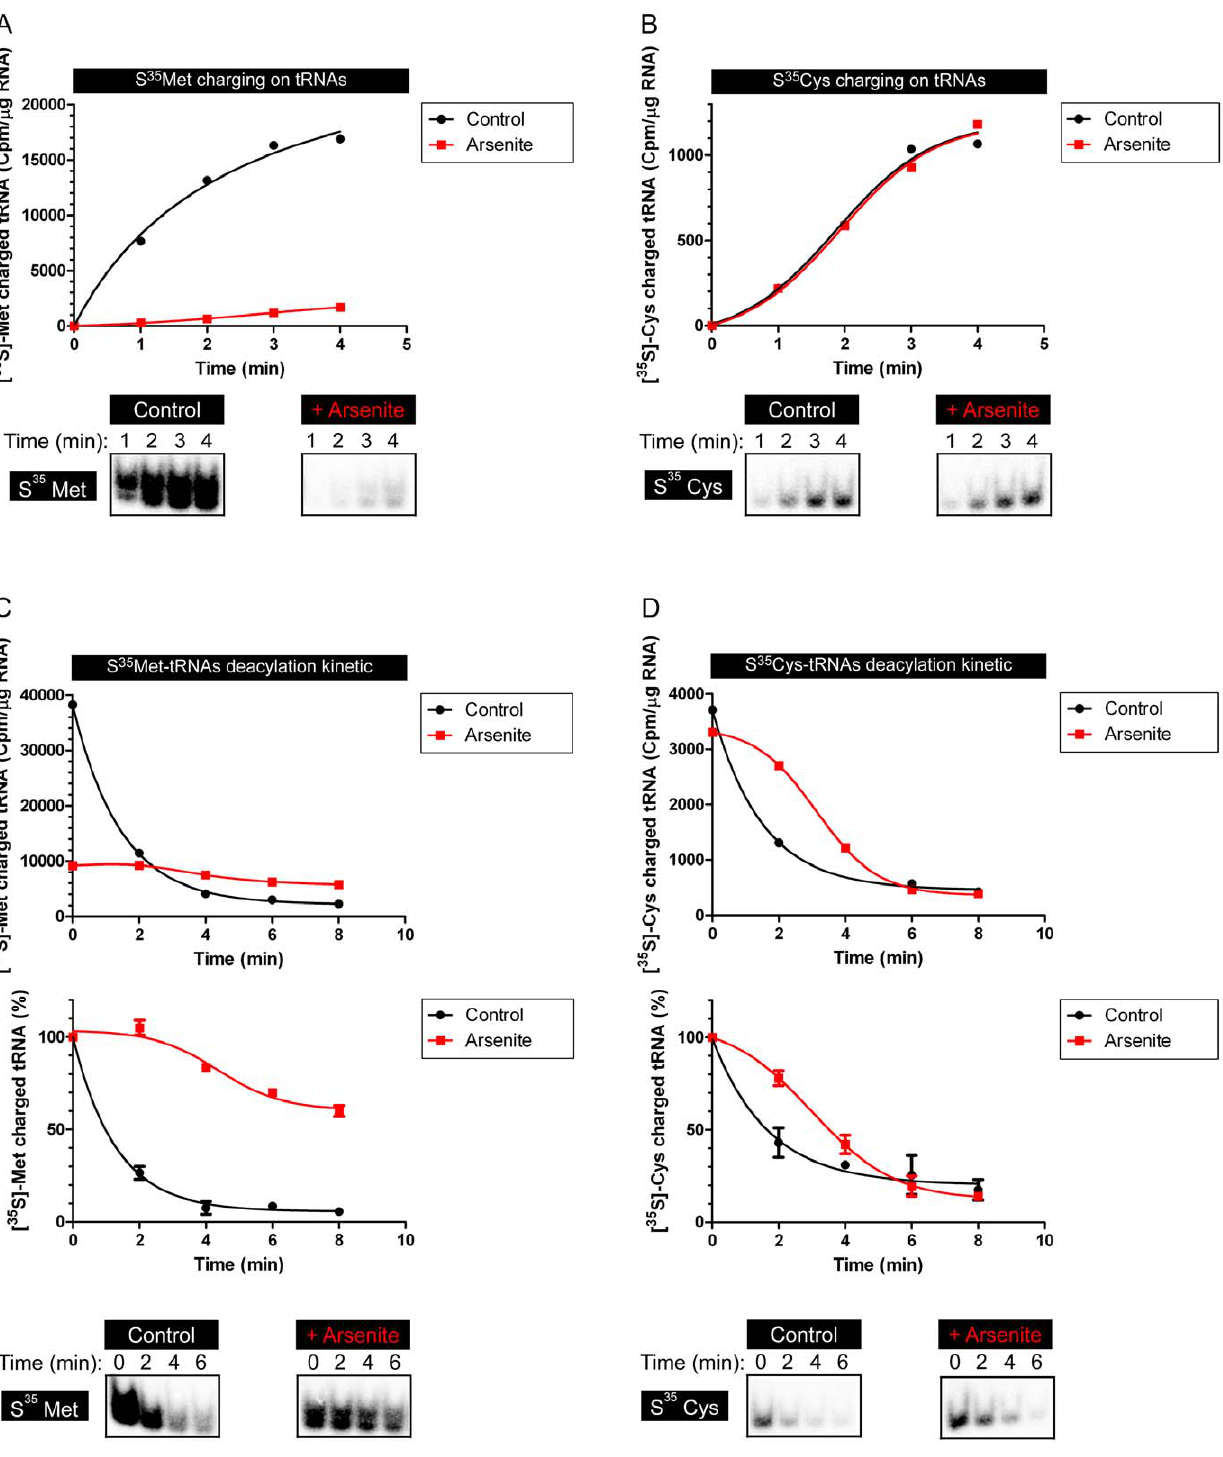
Figure 2. Cys-tRNA deacylation is uncoupled from translation. A. Kinetics of [ 35 S]-Met charging on tRNAs with or without pre-treating HeLa cells with sodium arsenite. The same samples were both analyzed by beta counter and loaded on a native acid gel. B. Same as ‘‘A’’ with [ 35 S]-Cys charging. C. Kinetics of [ 35 S]-Met deacylation on tRNAs extracted from HeLa cells pretreated or not with sodium arsenite. This panel shows two different graph representations: ‘‘raw’’ data using Cpm/ m g of total RNA and representing one experiment or calibrated data defining time 0 as 100% of [ 35 S]-Met charged tRNAs and averaging 2 distinct experiments. The same samples were both analyzed by beta counter and loaded on native acid gels. D. Same as ‘‘A’’ with [ 35 S]-Cys deacylation.